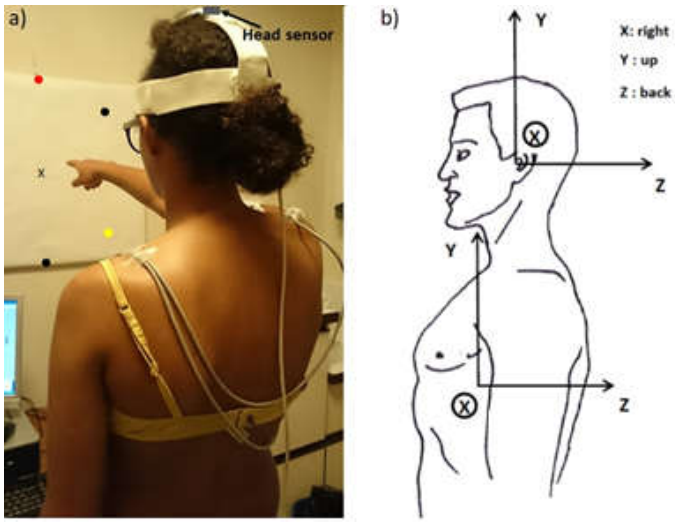
Figure 1. Experimental set-up. ( a ) Photo with the helmet (with head sensor) and targets, ( b ) schema of the reference frames. the reference